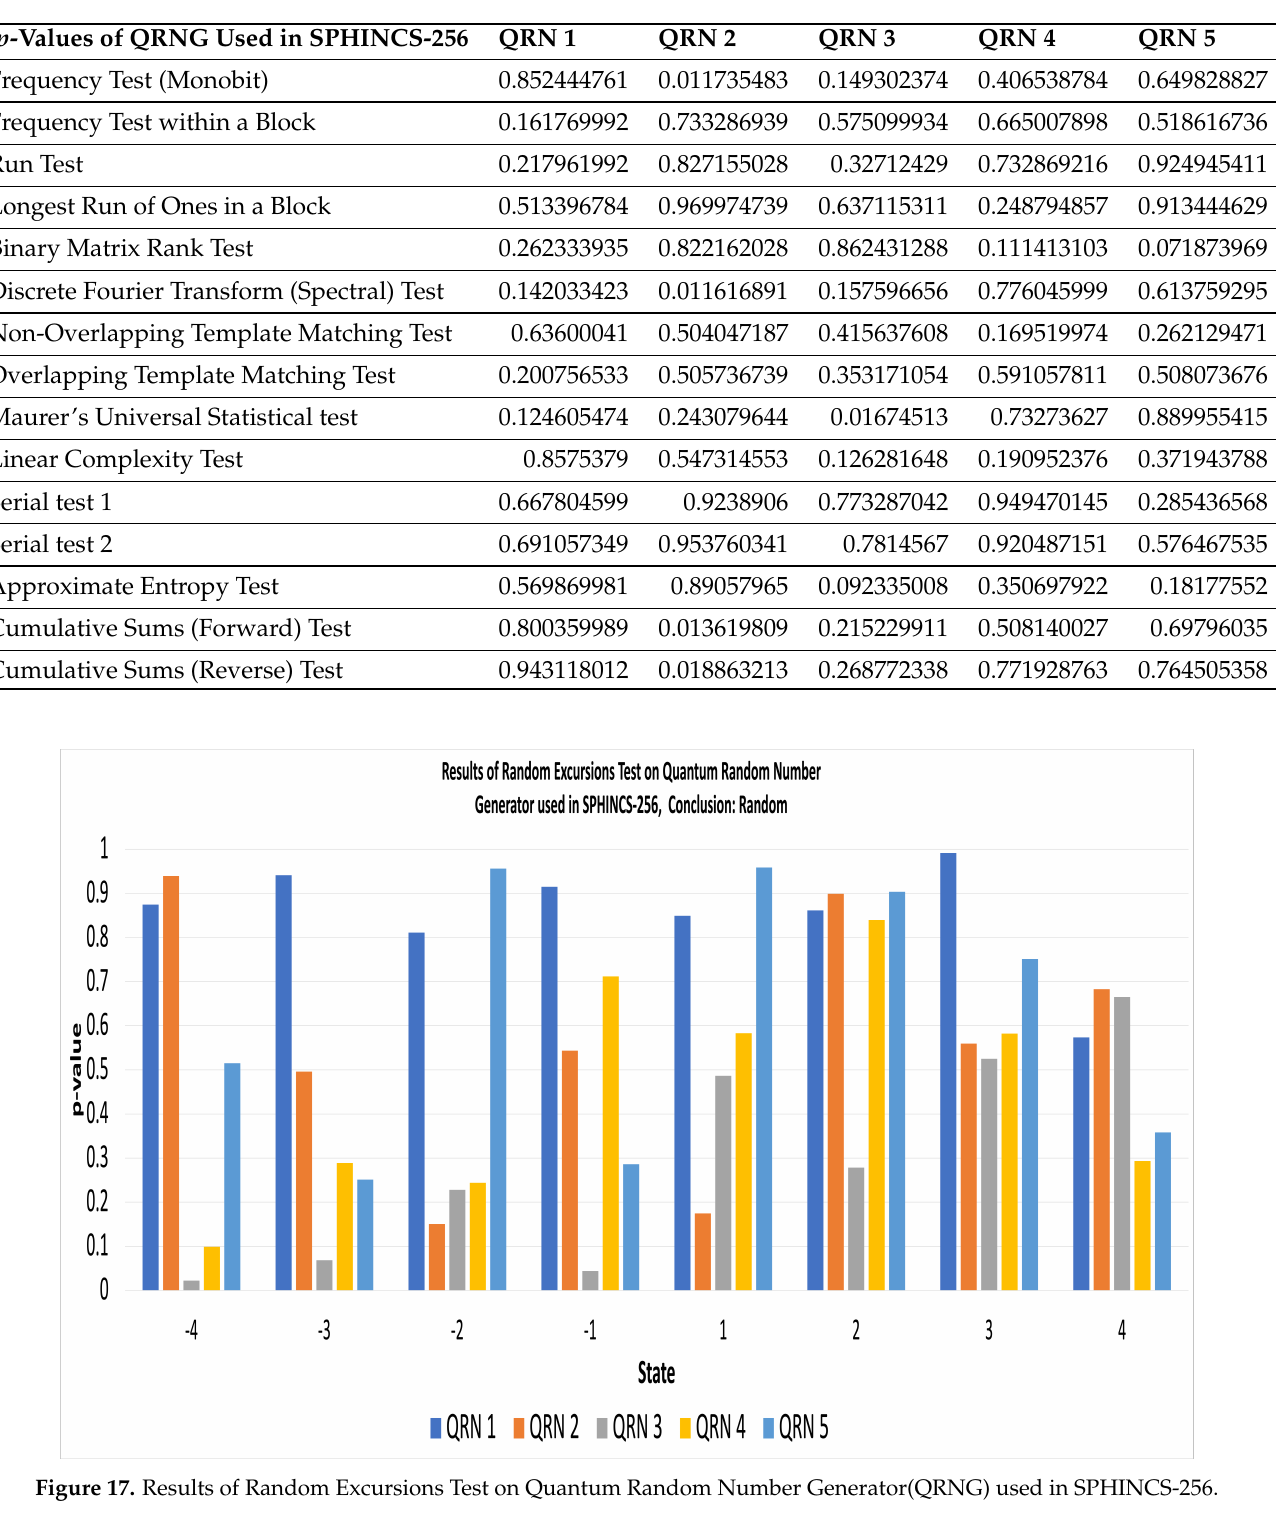
Table 7. p -values of appropriate NIST Statistical Tests for Random and PRNG applied on Quantum Random Number Generator(QRNG) used in SPHINCS-256.